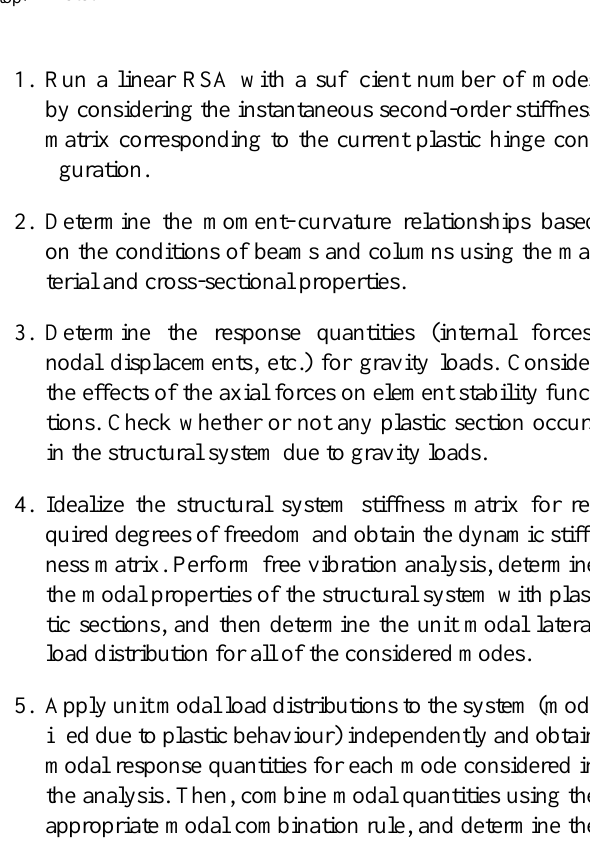
Figure 15. Base shear vs. roof drift response using different lateral load profiles for 6-storey building